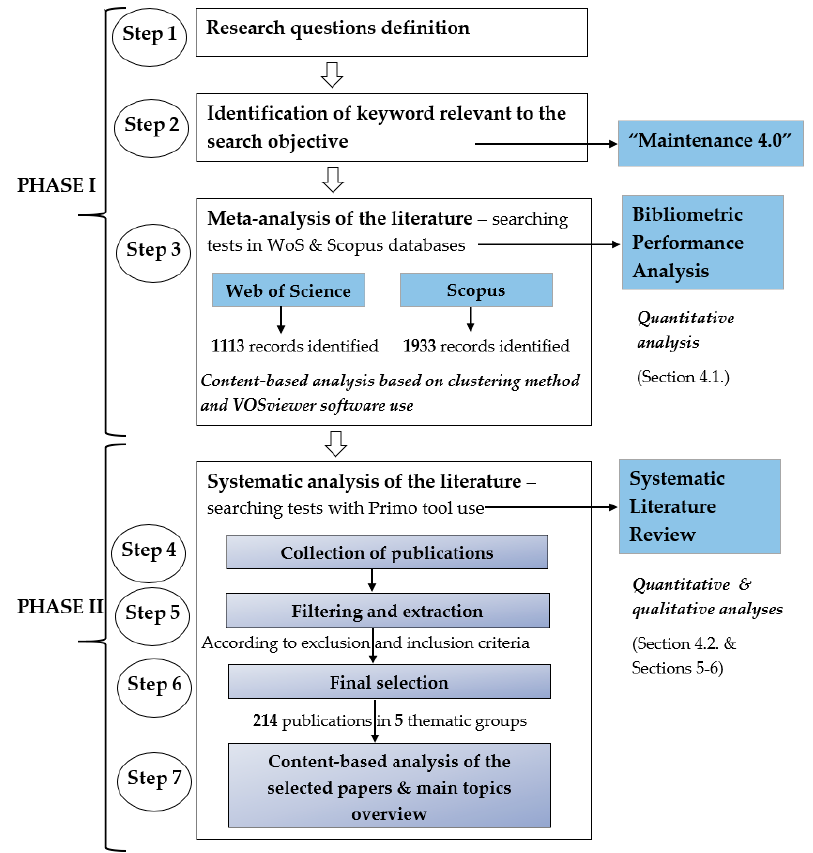
Figure 8. Research framework and methods/tools used. Source: own contribution